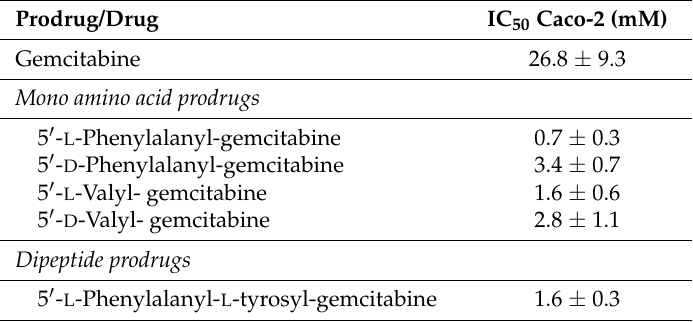
Table 4. [ 3 H] Gly-Sar uptake inhibition of gemcitabine and gemcitabine prodrugs in Caco-2 cells (mean ± S.D., n = 3).